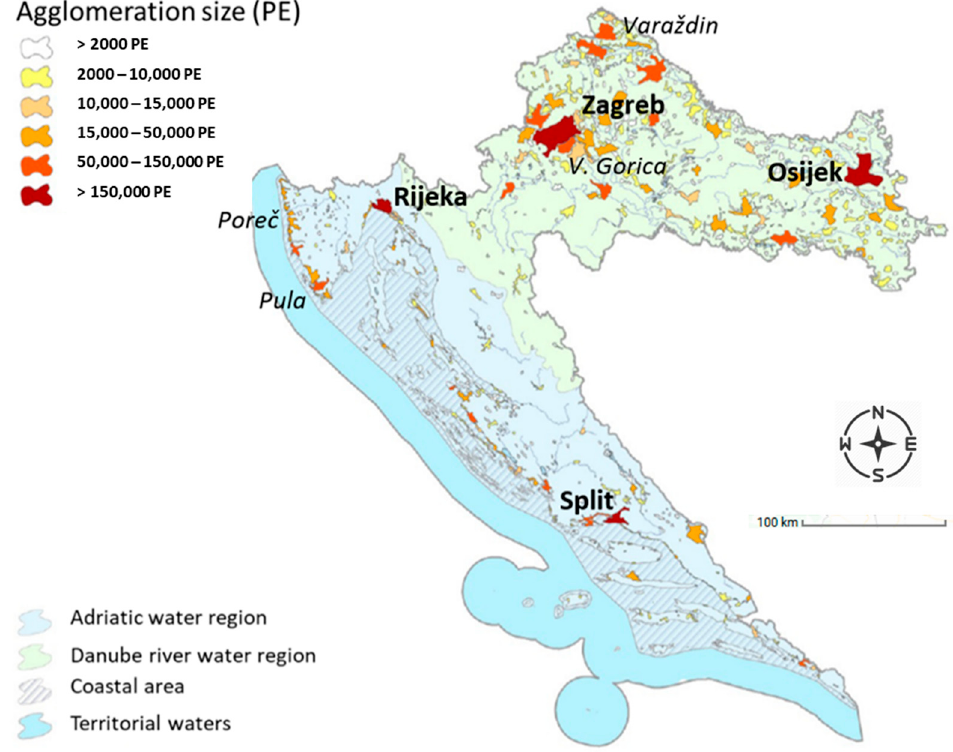
Figure 1. Spatial arrangement of agglomerations in Croatia.